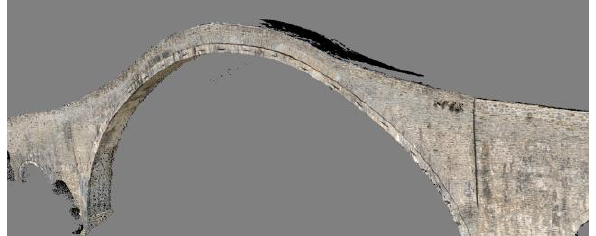
Figure 9: A view of the textured mesh created in Agisoft